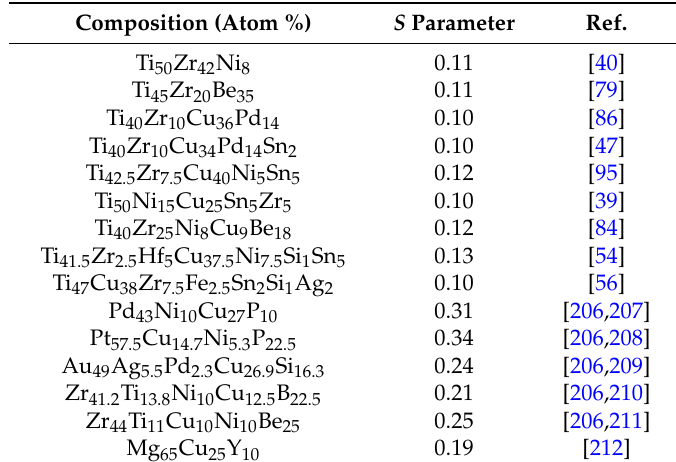
Table 7. Thermoplastic formability of typical Ti-based BMGs together with various BMG